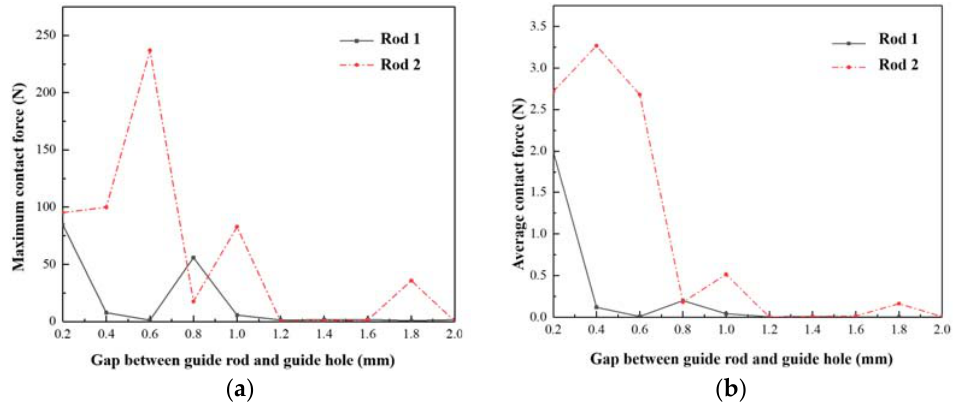
Figure 11. Maximum contact force and average contact force at different clearances. ( a ) Maximum contact force. ( b ) Average contact force.